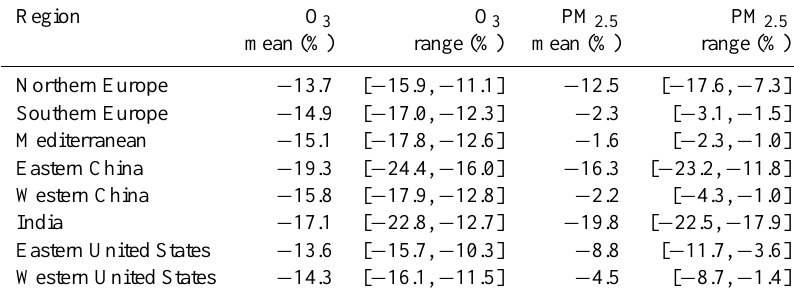
Table 4. Relative differences (%) in O 3 and PM 2 . 5 surface concentrations between simulations using the mitigation (MIT) and current legislation (CLE) scenarios (given as 100 × (MIT − CLE) / CLE) for several regions and for the final decade of the simulations (2041–2050). The regions correspond to the boxes shown in Fig. 10. Except for the Mediterranean, only the land-based grid cells inside the boxes were used. Mean values and full model ranges for the three models NorESM, HadGEM and OsloCTM2 are reported. To exclude effects of changes in sea salt and dust emissions caused by natural variability and emission responses to forced changes in meteorological conditions, sea salt and dust concentrations were kept at CLE levels for the purpose of these calculations. Region O 3 O 3 PM 2 . 5 PM 2 . 5 mean (%) range (%) mean (%) range (%) Northern Europe −